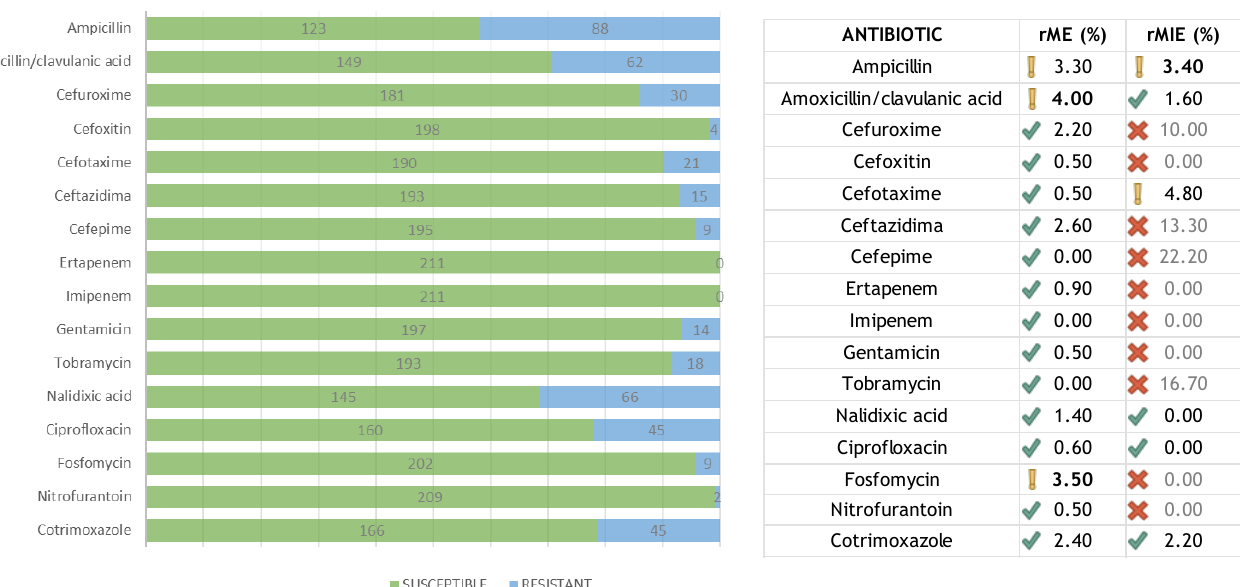
Table 2. Concordances for (A) bacteria, (B) turbidity, and (C) leukocytes and erythrocytes. The com- binations represent the number of combinations of sample / antibiotic.